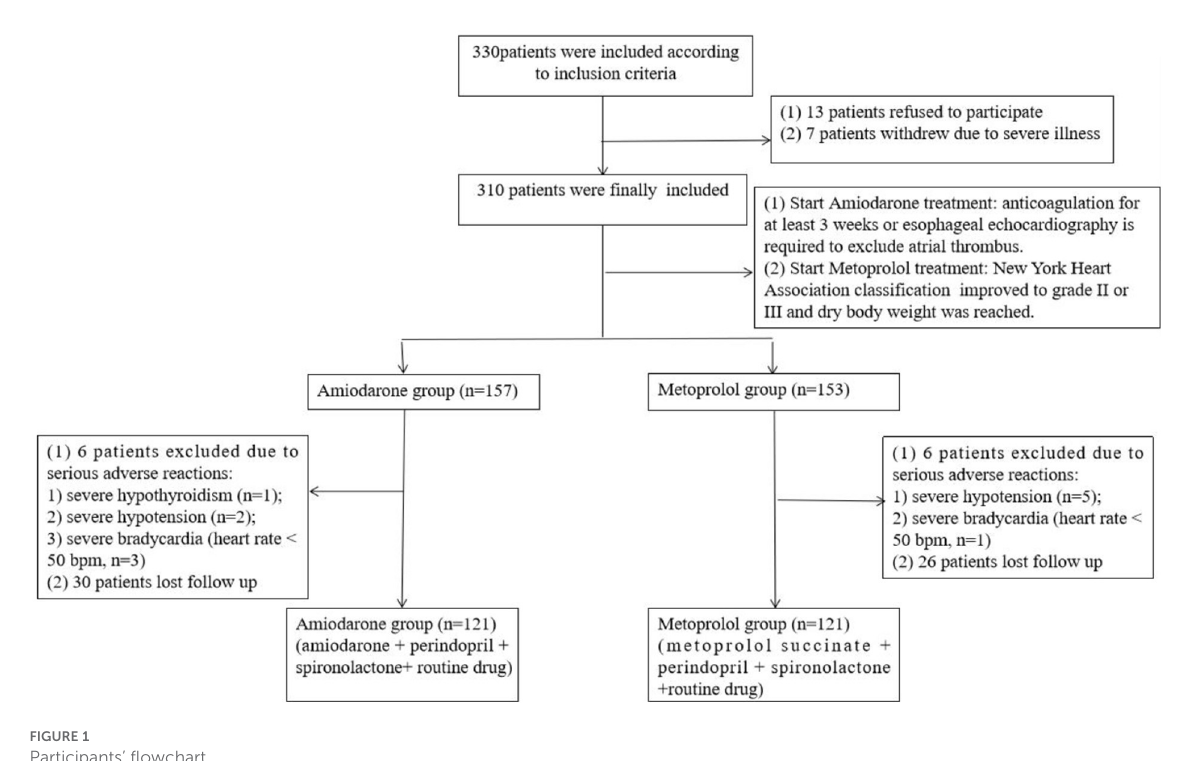
FIGURE1 Participants’ flowchart.